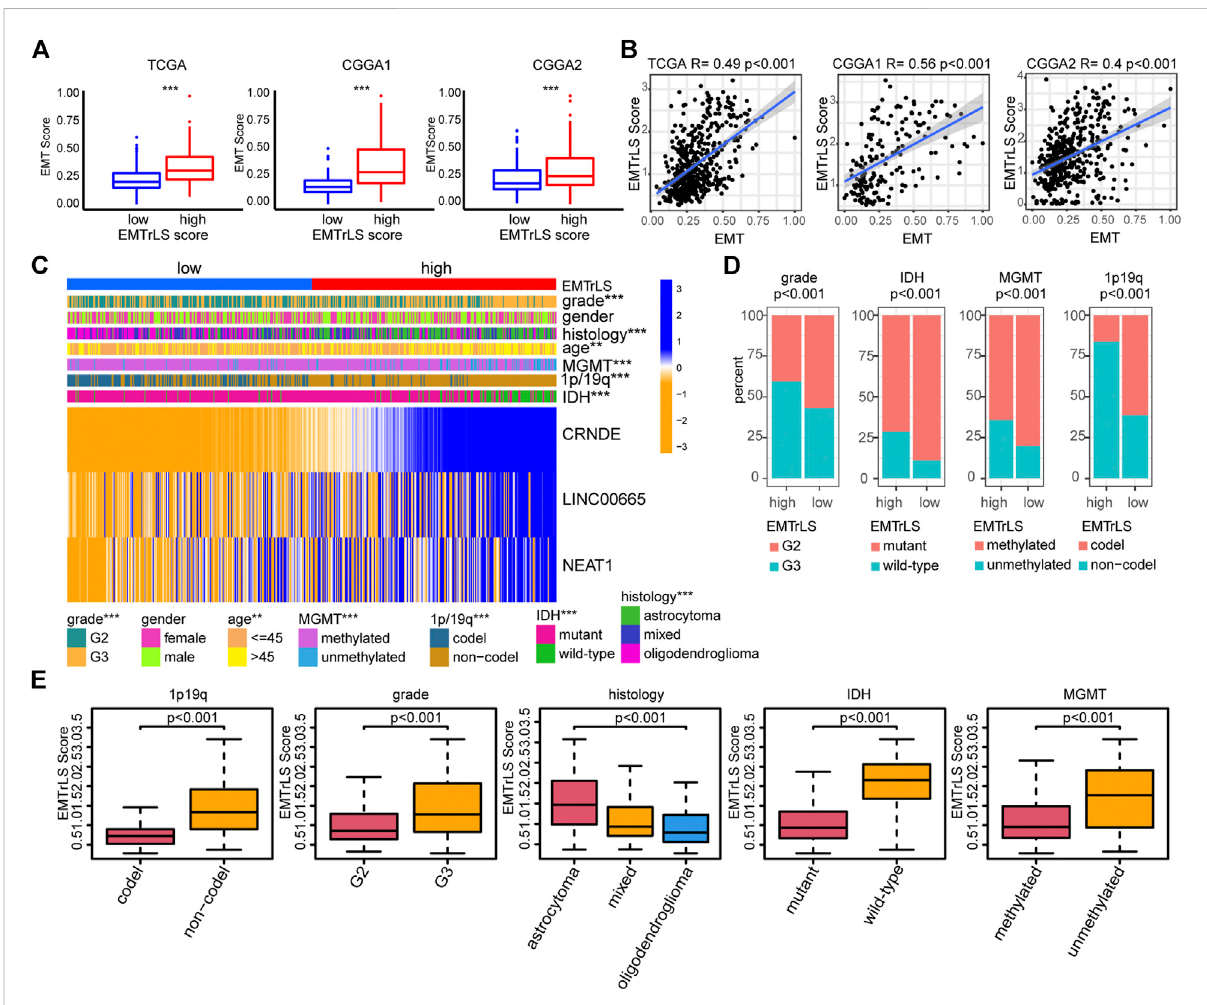
FIGURE 5 (A) The degree of EMT activation in the EMTrLS-high and -low cohorts in the three datasets (B) Spearman correlation analysis of EMT and EMTrLS scores (C) Heatmap showing the expression of hub genes and clinicopathological characteristics of two different EMTrLS groups based